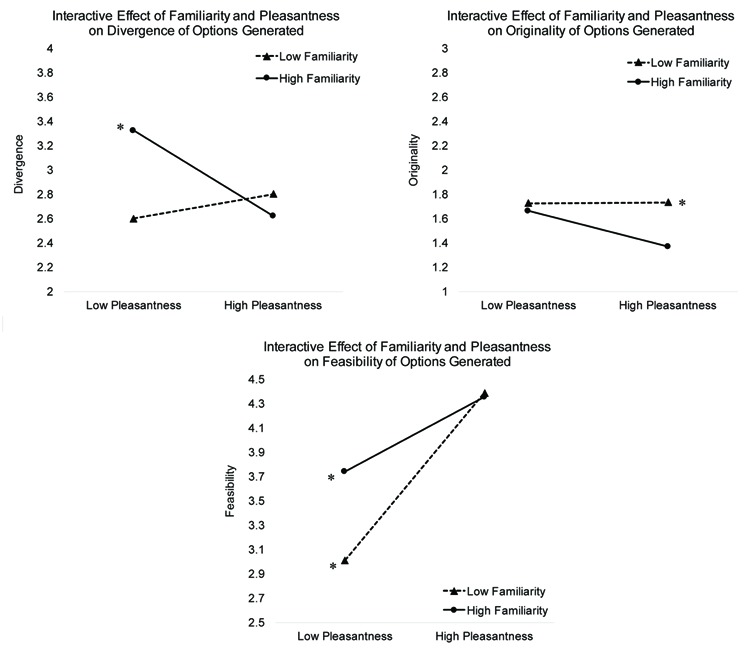
Depiction of the interactive effects of familiarity and valence on creative qualities of generated options. Asterisk denotes that the depicted simple slope is significant at ∗p < 0.01.+.